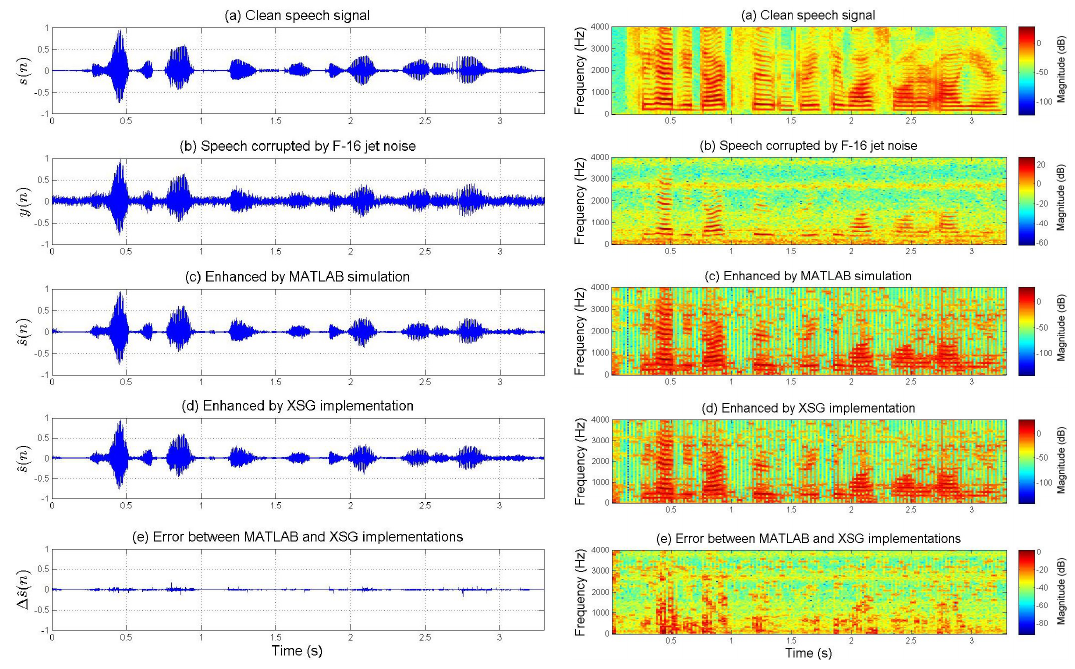
Figure 7. As in Figure 4 but for F-16 jet